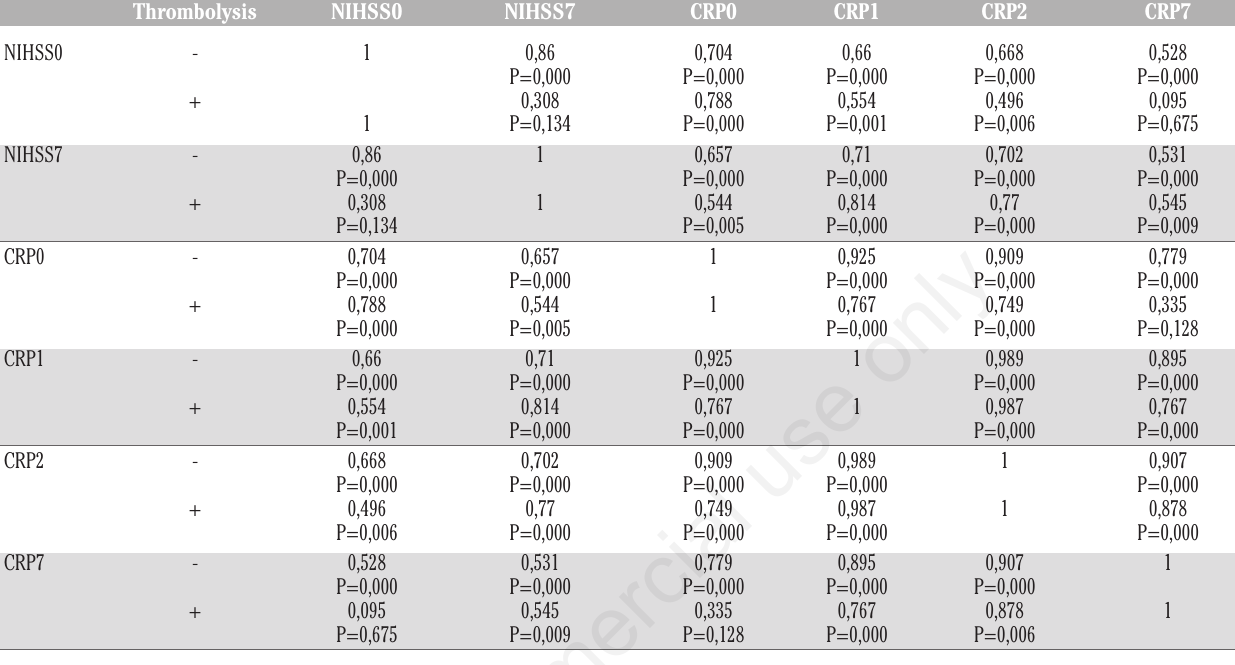
Table 1. Associations of NIHSS score at admission and at day seven and CRP values at admission, 24 hours, 48 hours and seven days after admission in both groups of